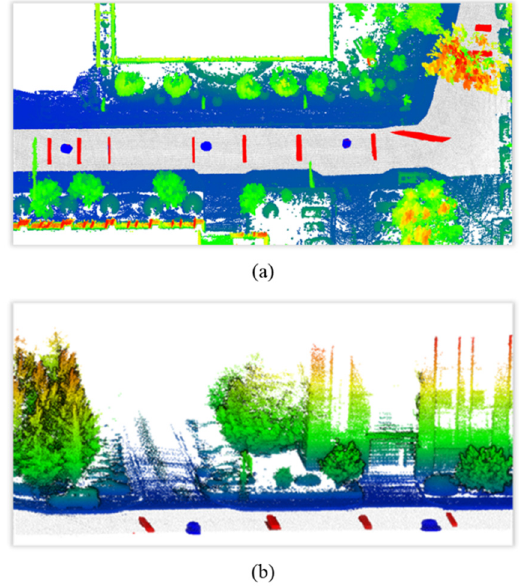
Figure 13. 3D point cloud map with subsurface target